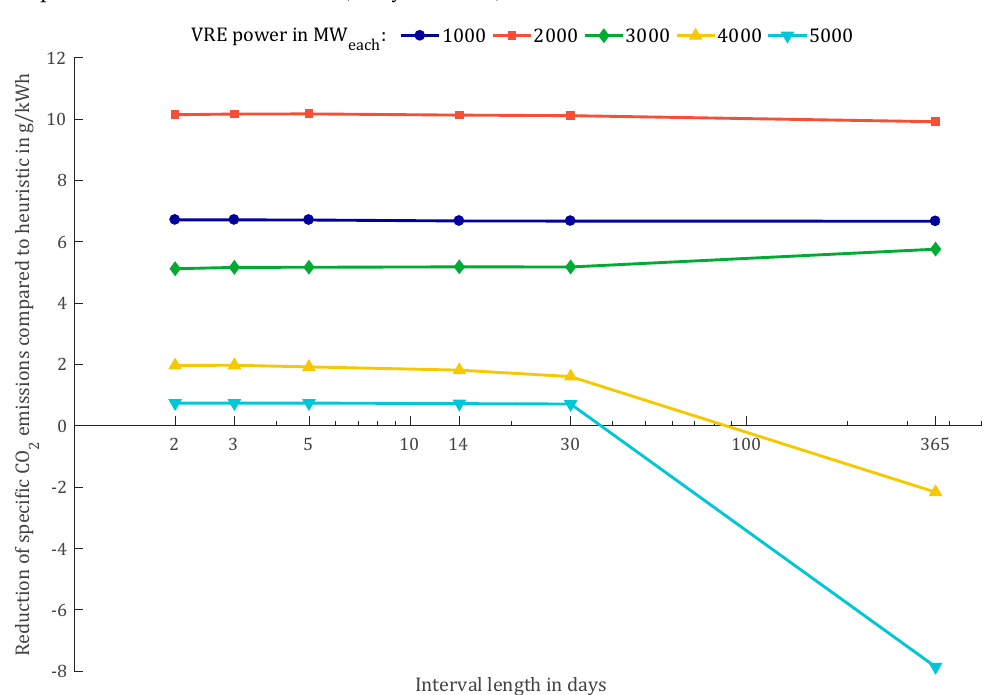
Figure 8. Reduction of specific CO 2 emissions through UCO compared to heuristic approach for different installed VRE powers (expressed in MW each ) and interval lengths.